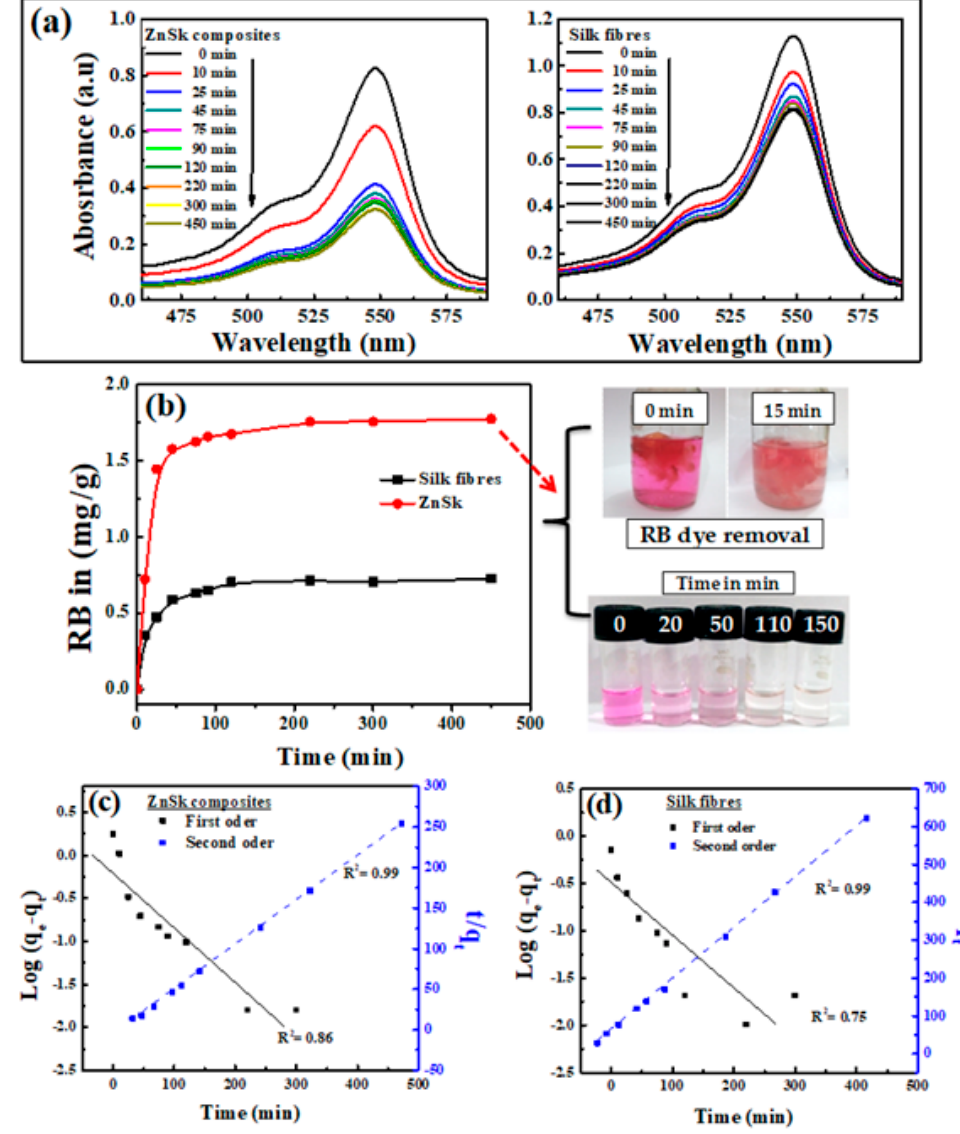
Figure 5. ( a ) UV-visible absorption spectra of Ross Bengal (RB) upon exposure to ZnSk composite and silk fibers. Initial concentration of RB used is 0.017 mM for ZnSk and 0.024 mM for silk fibers (for a 50 mL working volume solution). Weights of adsorbents used are 0.335 g (for ZnSk) and 0.477 g (for silk fiber). ( b ) The absorption threshold is shown in graph with RB color changes in the presence of ZnSk with time as a picture insert. Graphs from ( c , d ) correspond to first order and second order models for the adsorption of RB by ZnSk composites and silk